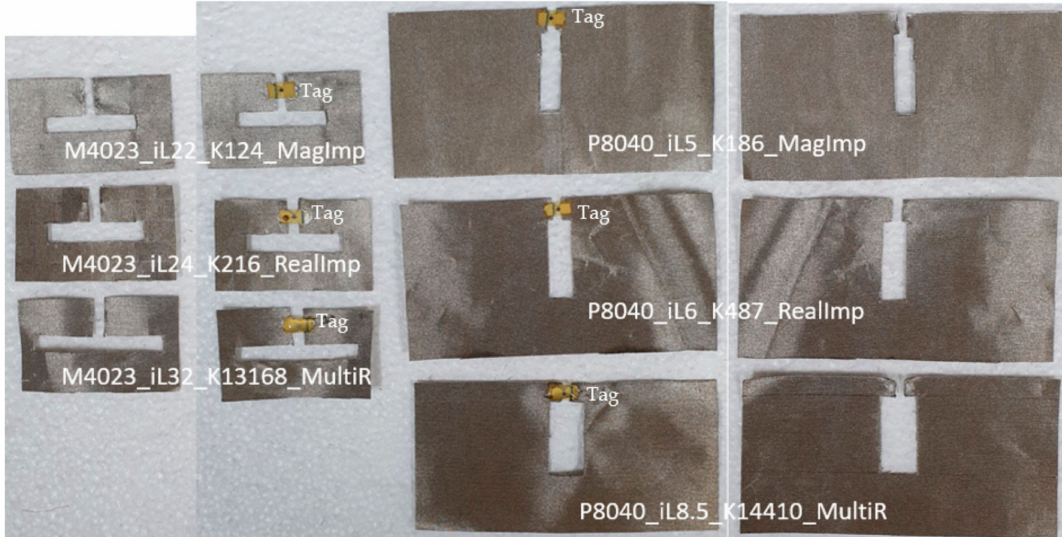
Figure 10. Fabricated M4023 and P8040 CFTA tag antenna optimized with different K